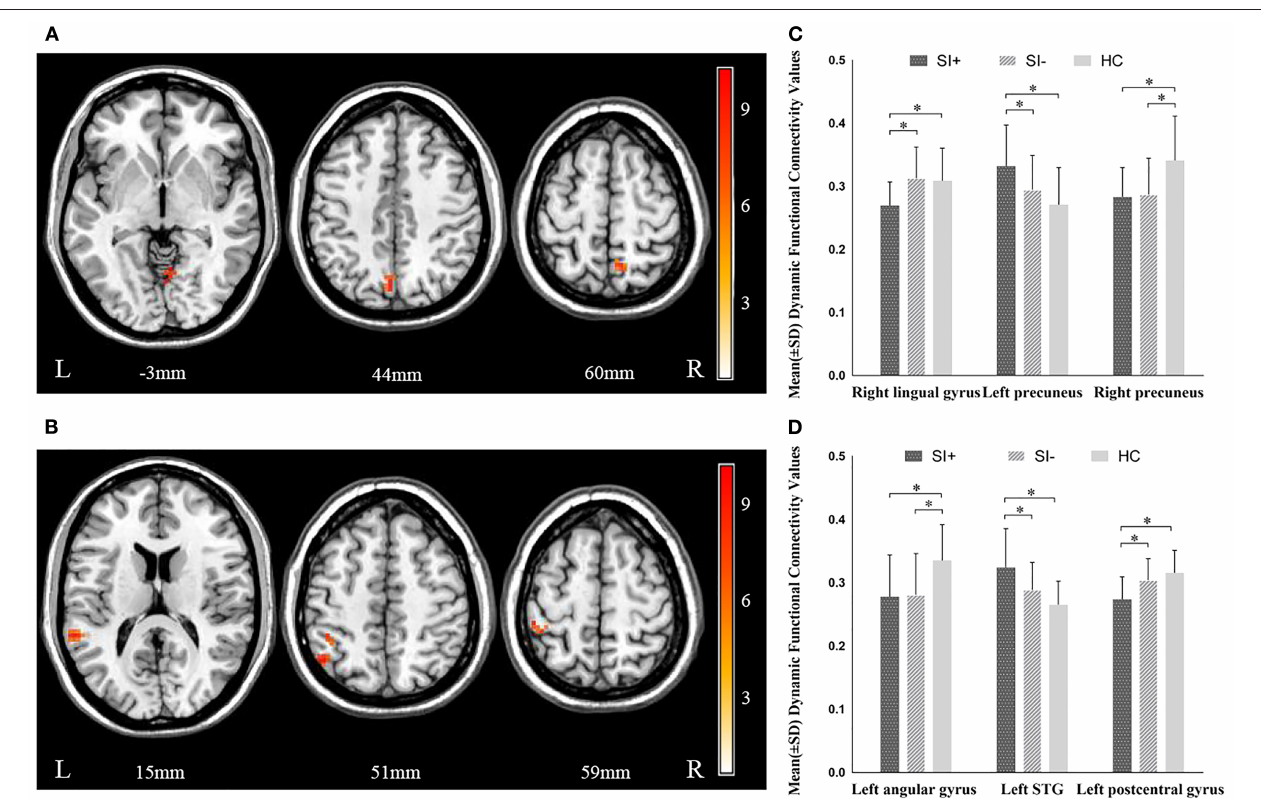
FIGURE 2 | Significant differences in dynamic functional connectivity (dFC) of (A) left habenula and (B) right habenula among the major depressive disorder with suicidal ideation (SI + ), MDD without suicidal ideation (SI–), and healthy control (HC) groups. The color bars indicate the F value based on one-way ANOVA. Significant at P < 0.001, corrected by Gaussian random field (GRF) correction. Post hoc comparison in dynamic functional connectivity (dFC) of (C) left habenula and (D) right habenula among the major depressive disorder with suicidal ideation (SI + ), MDD without suicidal ideation (SI–), and healthy control (HC) groups. * P < 0.05, corrected by Bonferroni test. STG, superior temporal